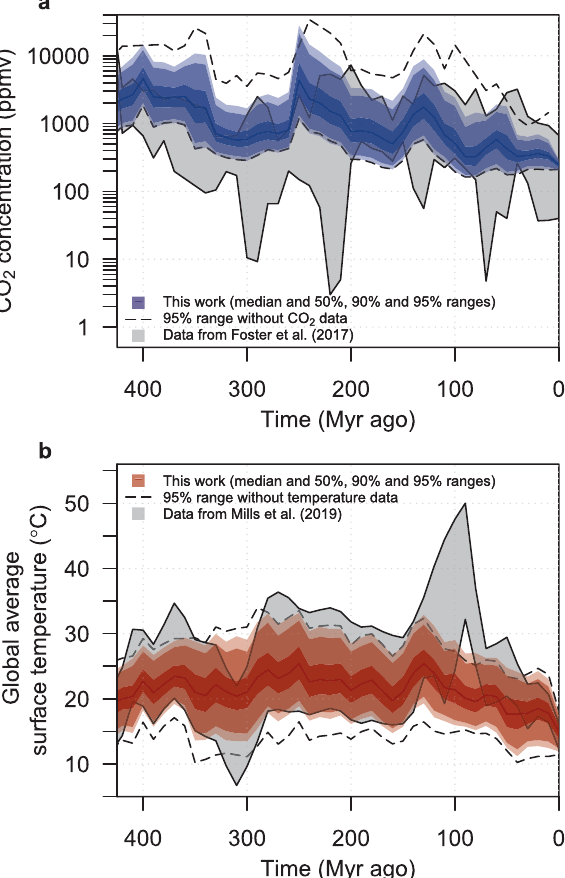
Fig. 4 Model hindcast, using both CO 2 and temperature data, for precalibration and a %outbound threshold of 30% (shaded regions). The gray-shaded regions show the data compilations for CO 2 (ref. 26 ) and temperature 12 . The lightest colored shaded regions denote the 95% probability range from the precalibrated ensemble, the medium shading denotes the 90% probability range, the darkest shading denotes the 50% probability range, and the solid-colored lines show the ensemble medians. To depict the marginal value of each data set, the dashed lines depict the 95% probability range from the precalibrated ensemble, when only temperature data is used ( a ) and when only CO 2 data is used ( b